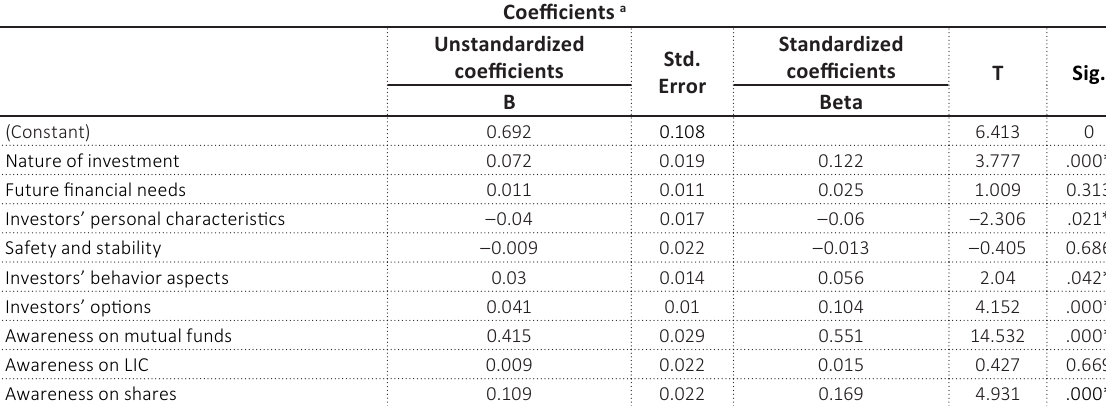
Table 10. Regression